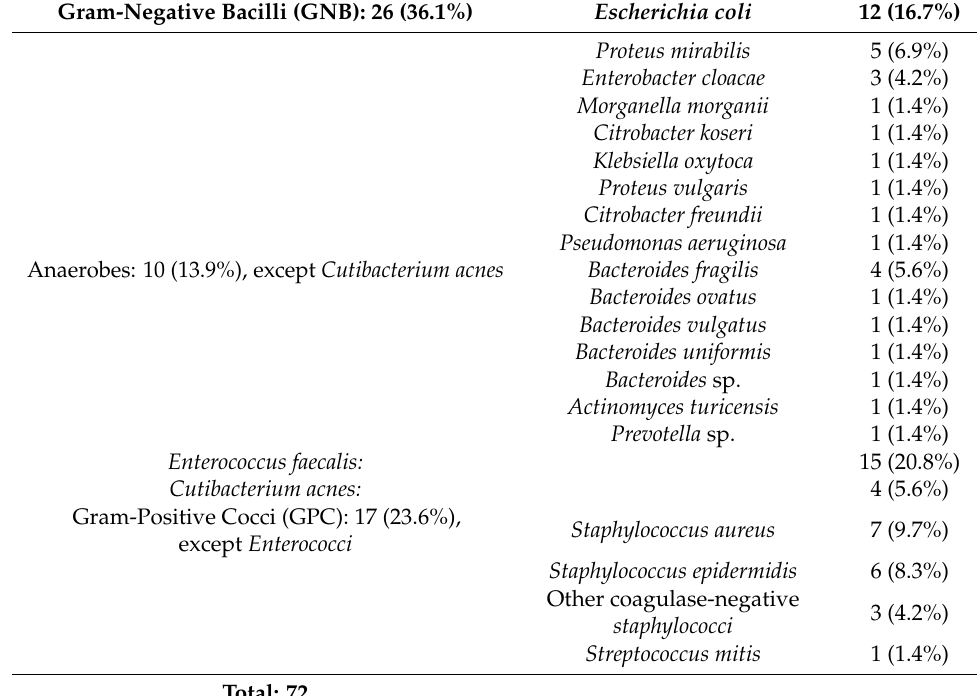
Table 3. Ecology and distribution of the microorganisms involved in the SSIs. Gram-Negative Bacilli (GNB): 26 (36.1%) Escherichia